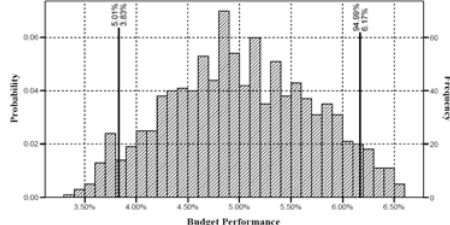
Probability density distribution for budget performance, 1,000 simulated